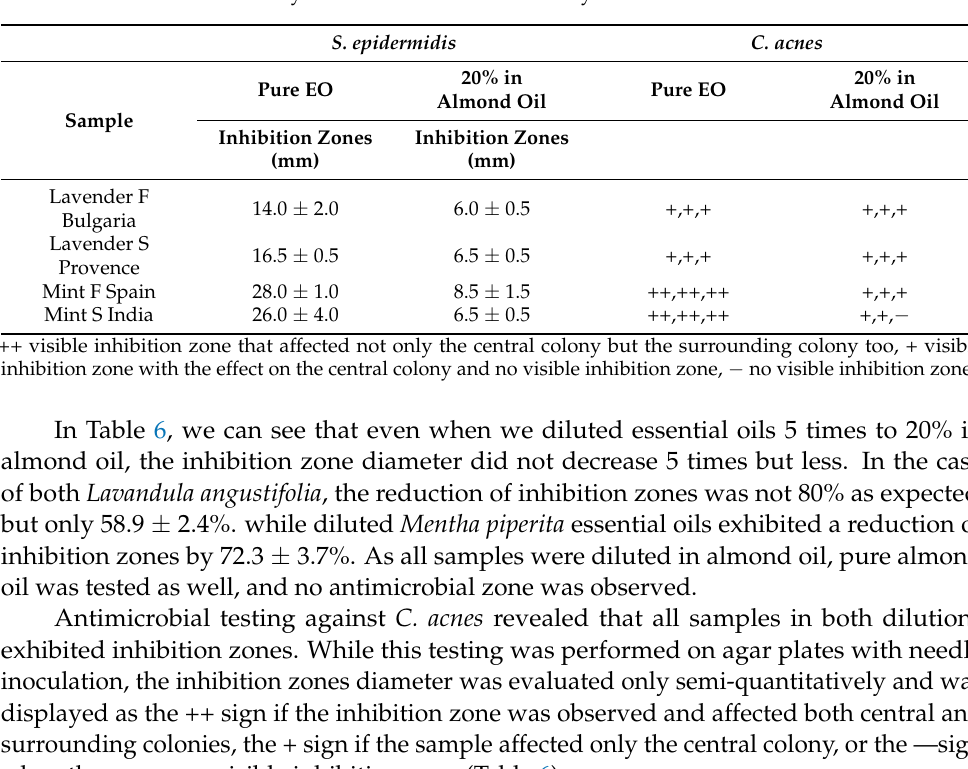
Table 6. Antimicrobial activity of essential oils measured by disc diffusion